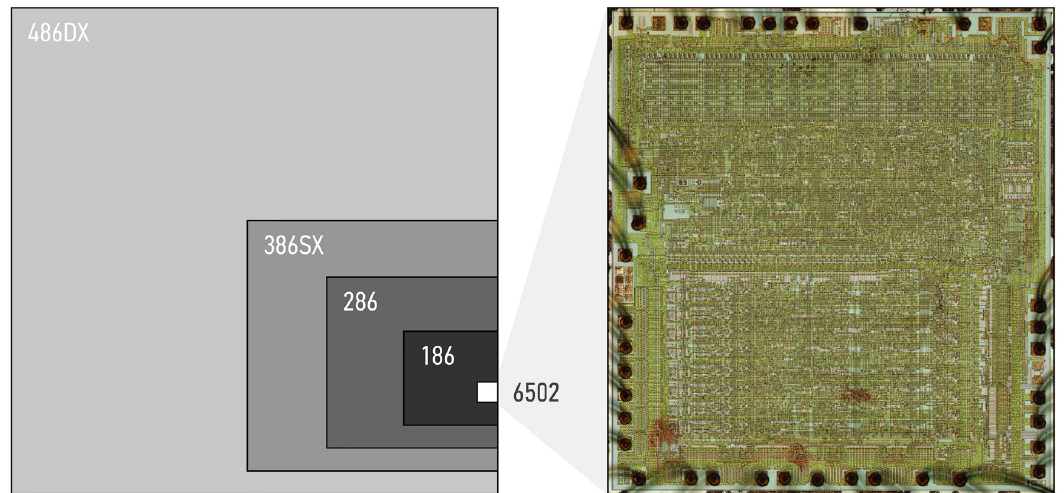
Fig 1. Comparing die sizes and transistor counts. Relative die sizes of different processors had they been produced with the same manufacturing process as the 6502 shown on the right. Areas scale roughly with the number of transistors on the chip. The size of the 6502 die is 3.9 × 4.3 mm 2 . High-resolution photograph of the 6502 die: visual6502.org .